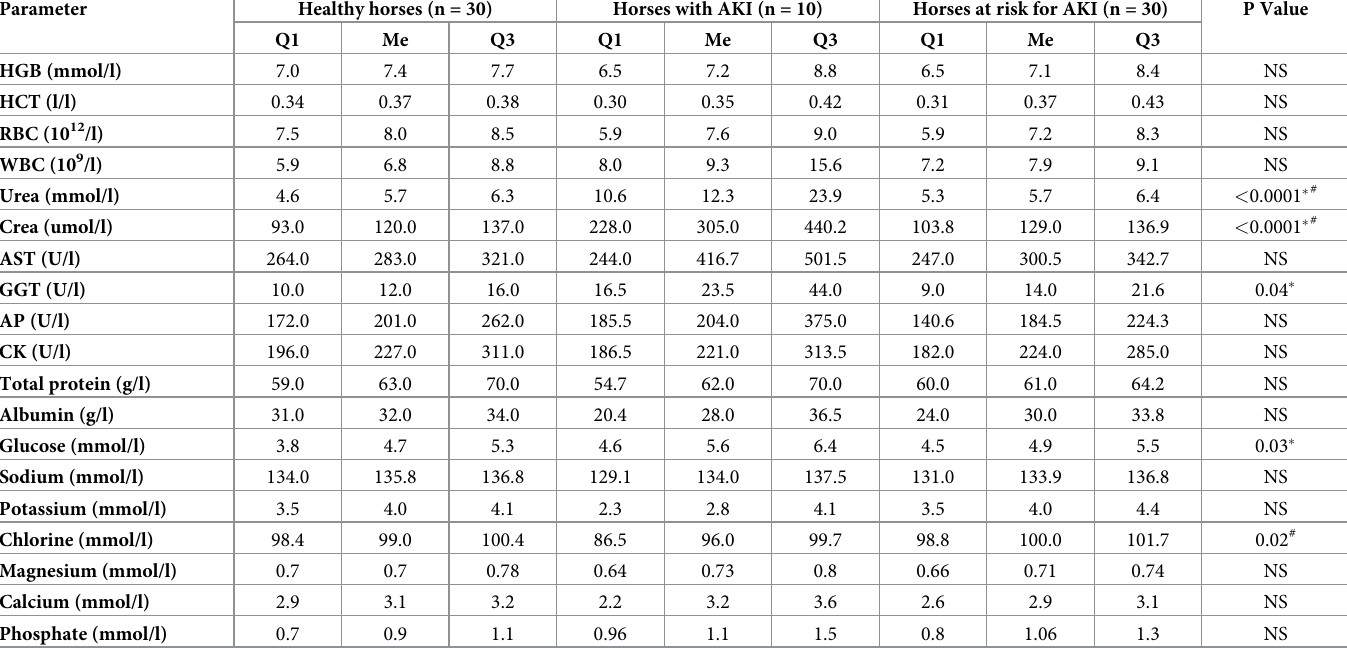
Table 1. Hematological and biochemical blood results of healthy horses, horses with clinical kidney dysfunction (horses with AKI) and horses at risk for acute kid- ney injury. Parameter Healthy horses (n = 30) Horses with AKI (n = 10) Horses at risk for AKI (n = 30) P Value Q1 Me Q3 Q1 Me Q3 Q3 HGB (mmol/l) HCT (l/l)